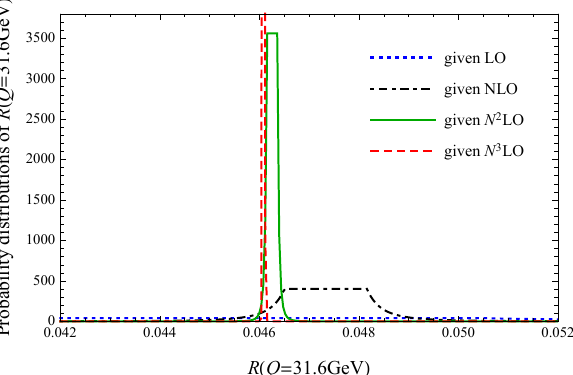
Figure 9. The probability density distributions of R ( Q = 31.6 GeV ) with different states of knowledge predicted by PMCs and BA. The blue dotted, the black dash-dotted, the green solid, and the red dashed curves represent the results with given LO, NLO, N 2 LO, and N 3 LO series,